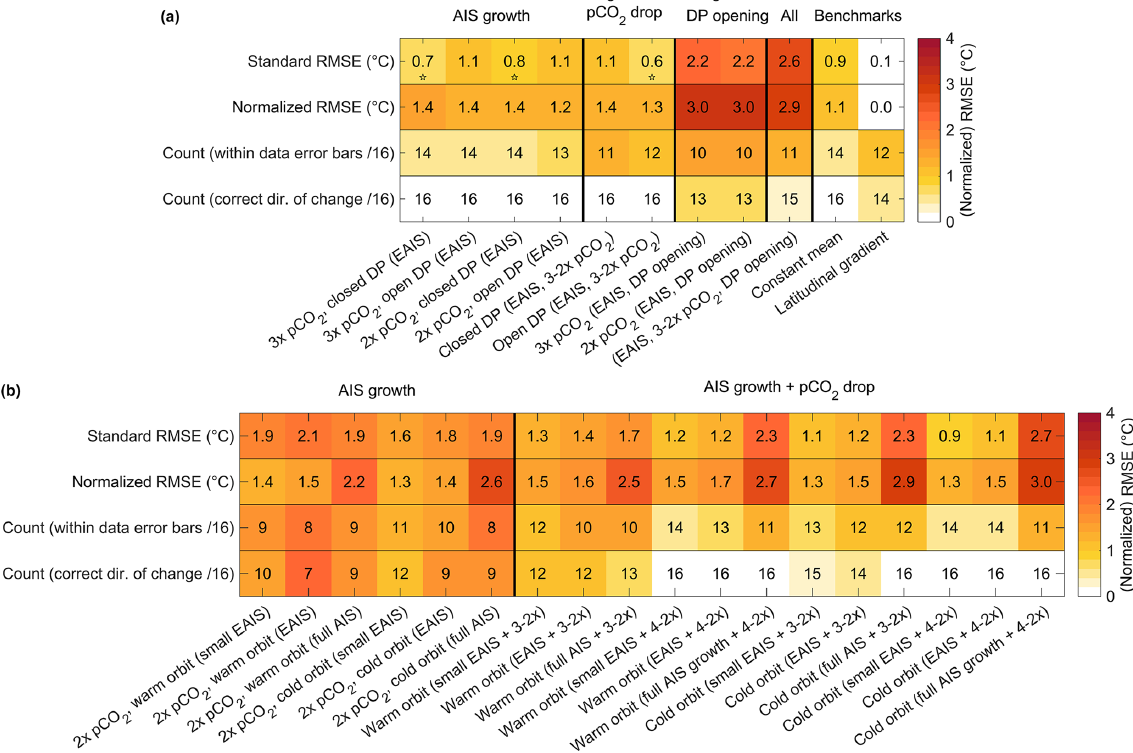
Figure 5. Standard RMSE ( ◦ C), normalized RMSE ( ◦ C) and count metrics for the annual mean temperature from all pairs of model simula- tions representing the forcing across the EOT compared against the EOT dataset from HadCM3BL and the benchmarks (a) and FOAM (b) . The simulation pairs are grouped by forcing. Labels on the x axis are similar to Fig. 4, with changes in boundary conditions associated with each pair of simulations written in brackets. The colour scales of the count metrics are normalized to match that of the RMSE metrics, and stars indicate moderate to good performance as in Fig.